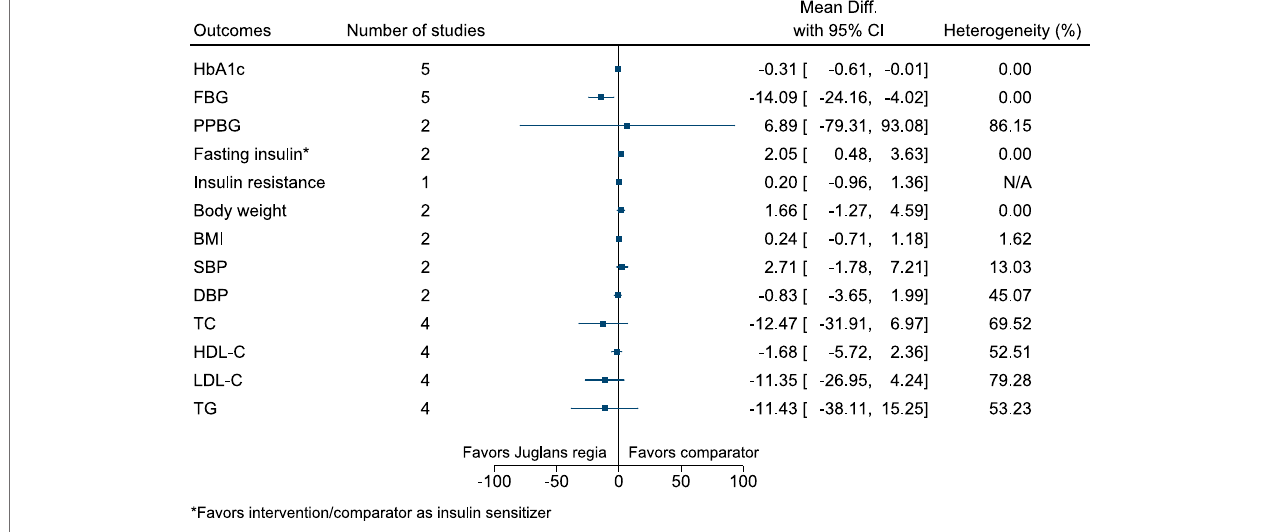
FIGURE 21 | Juglans regia — Summary forest plot.